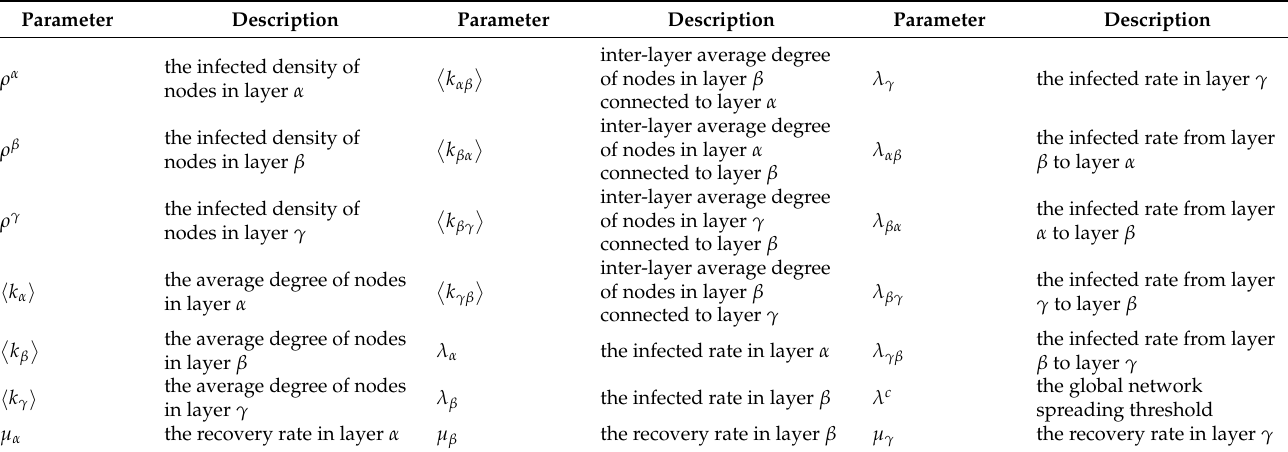
Table 3. Descriptions of experimental